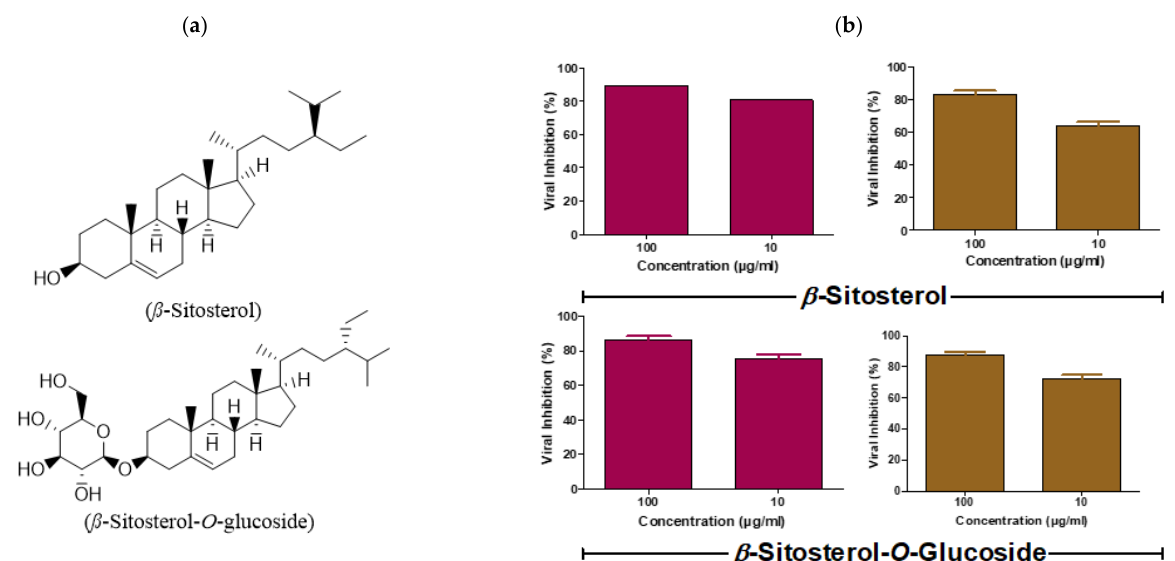
Figure 3. Concentration‑dependent viral titer reduction for the highly promising steroids ( β ‑sitosterol and β ‑sitosterol‑ O ‑glucoside) as determined via PRA. ( a ) Chemical structure of β ‑sitosterol and β ‑sitosterol‑ O ‑glucoside; ( b ) Validation of the anti‑influenza efficacy for both compounds were evaluated against the A/H1N1 (dark pink) and the A/H5N1 (light brown), and GraphPad Prims 5.01 software was used to plot the viral inhibition percentages against compound